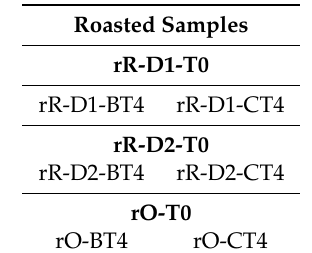
Table 2. Samples of roasted